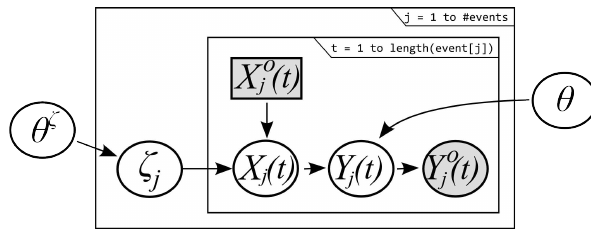
Fig. 1. Schematic representation of the rainfall multipliers and the rainfall-runoff model. j refers to the number of the rainfall event, X O (t) and Y O (t) are the observed rainfall and runoff for the j th j j event at time t , respectively. X j (t) is the inferred rainfall and Y j (t) the modelled runoff for the j th event. ζ j is the rainfall multiplier for the j th event. θ are parameters of a model and θ ζ – parameters of the rainfall multipliers distribution (mean and variation) over all j